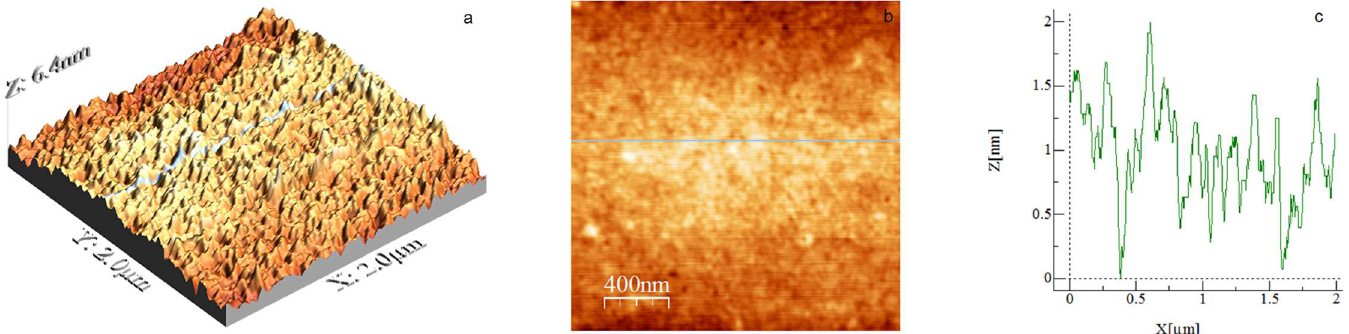
Fig 1. AFM image of a BSA-coated glass slide. Scan size is 2 × 2 μ m 2 . (a) 3D image, (b) 2D image and c) height profile corresponding to the position signalled by the green line in (b).